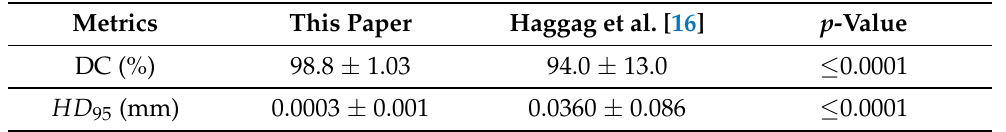
Figure 9. Segmentation sample when distance map is removed from fused images but with greater number of training epochs. There are large segmentation errors. Table 1. Segmentation accuracy comparison of the proposed approach and the previous technique based on U-CNN only [16], using both area and distance-based metrics.